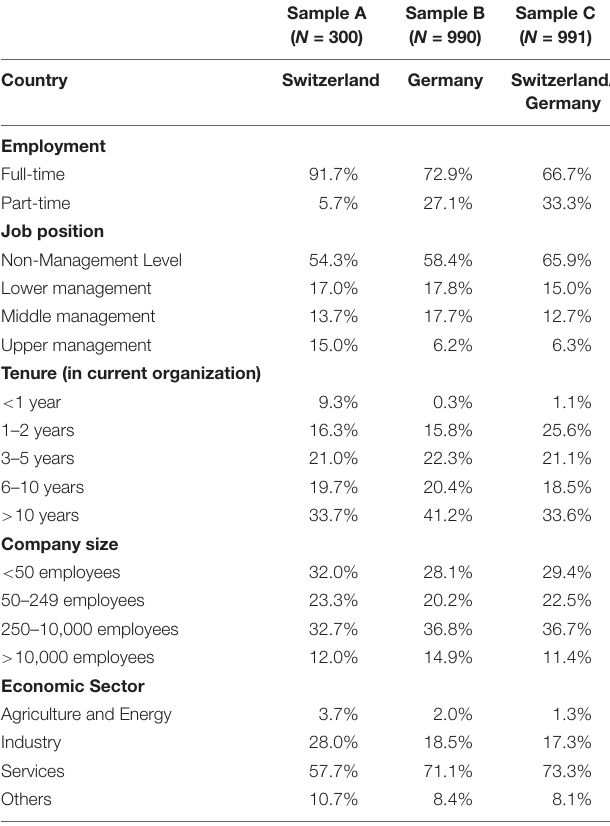
TABLE 1 | Further work-related descriptive statistics of Samples A, B, and